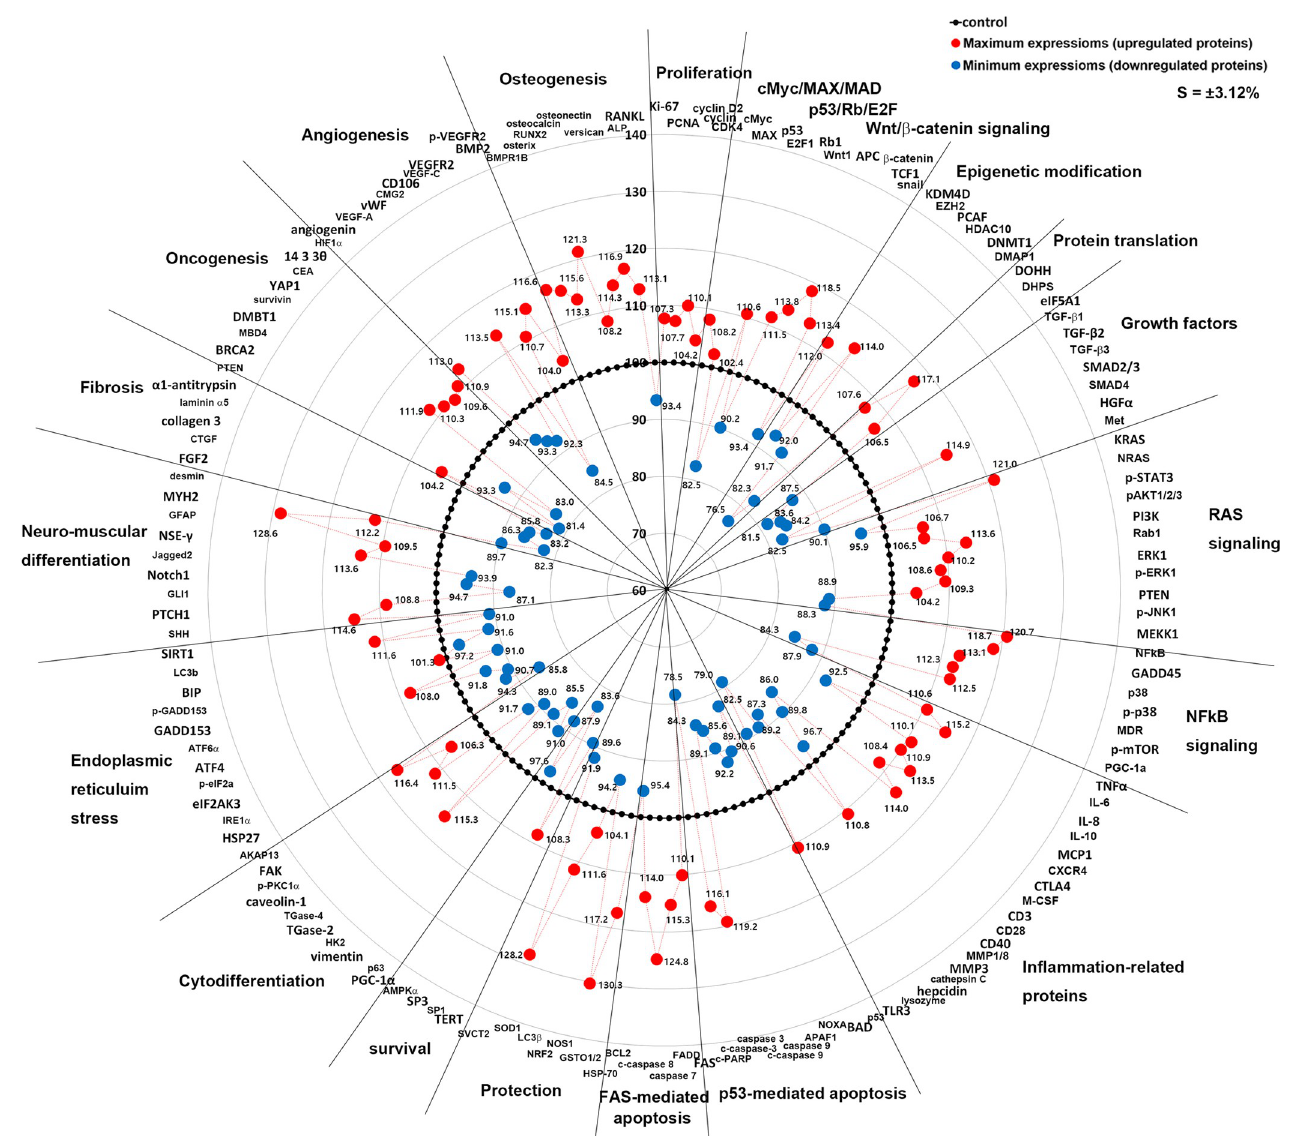
Fig 16. Star plot of global protein expression in RAW 264.7 cells treated with 10 μ g/mL PTX. The representative proteins (n = 150) were selected and their maximum or minimum expression levels (%) were plotted in a circular manner. 21 major signaling pathways showed different levels of protein expression. 10 μ g/mL PTX activated the growth factors, epigenetic modification, protein translation, RAS and NFkB signaling, protection, neuromuscular ad osteoblastic differentiation, acute inflammation associated with innate immunity and cell-mediated immunity, but inactivated ER stress, fibrosis, and chronic inflammation. FAS-mediated apoptosis was enhanced contrary to p53-mediated apoptosis. Also noted that the upregulation of oncogenic proteins and the downregulation of tumor suppressor proteins. Red circle: maximum expression of upregulated proteins. Blue circle: minimum expression of downregulated